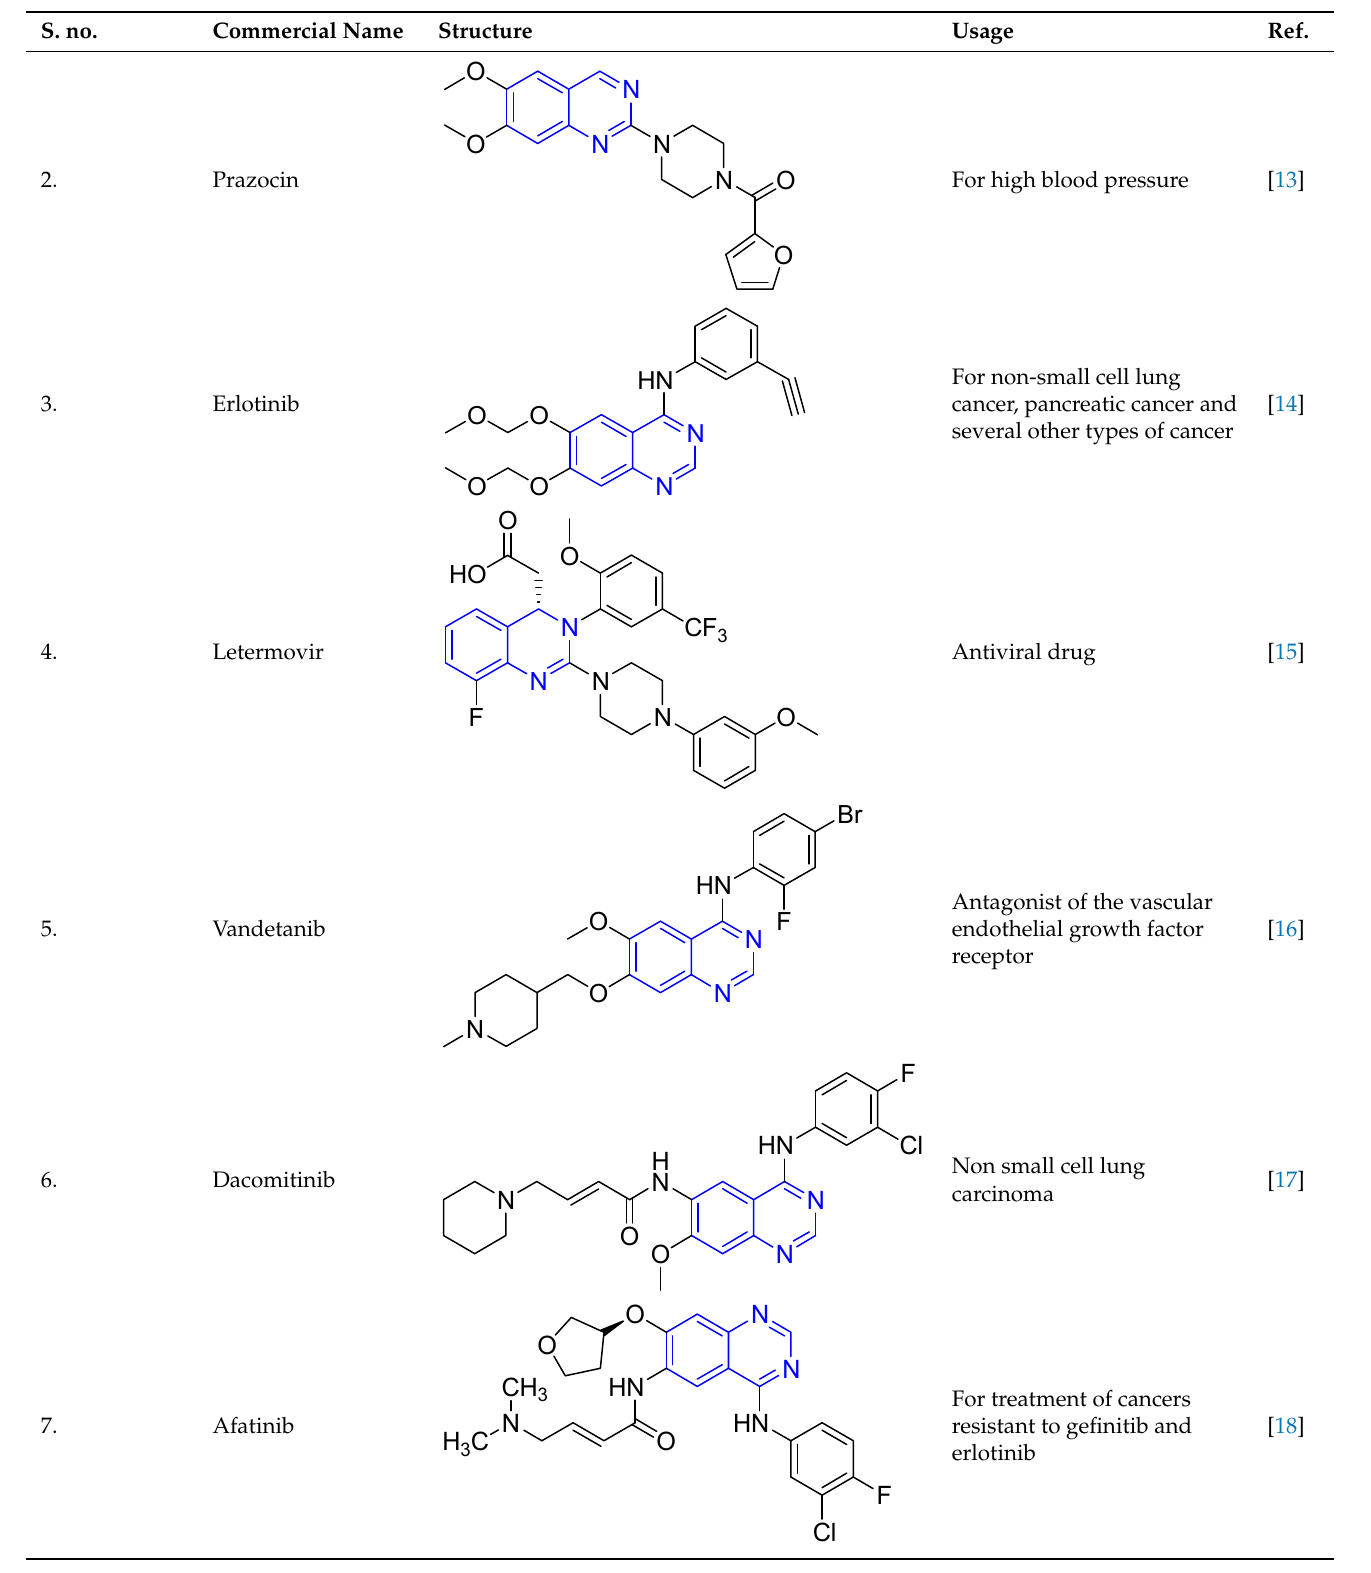
Table 1. Quinazoline based commercial drugs.